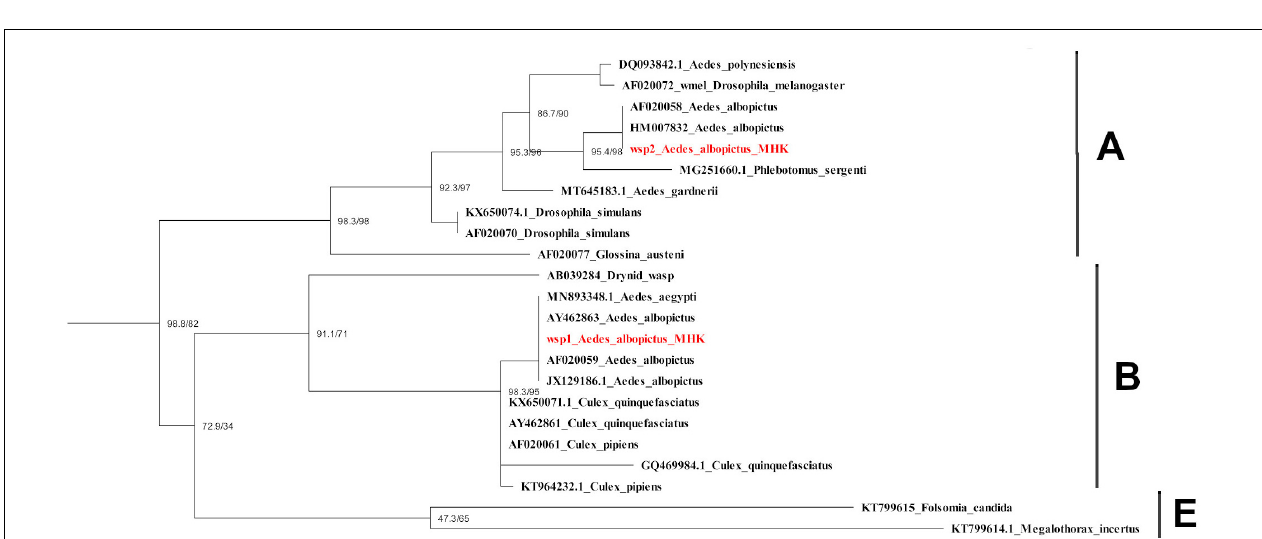
FIGURE 8 | Phylogenetic tree of Wolbachia Wsp gene obtained from Ae. albopictus mosquitoes in Manhattan, KS, United States. Sequences identified in this study are labeled in red. Scale bar indicates the number of substitutions per site. Wsp: Wolbachia surface protein. KS: